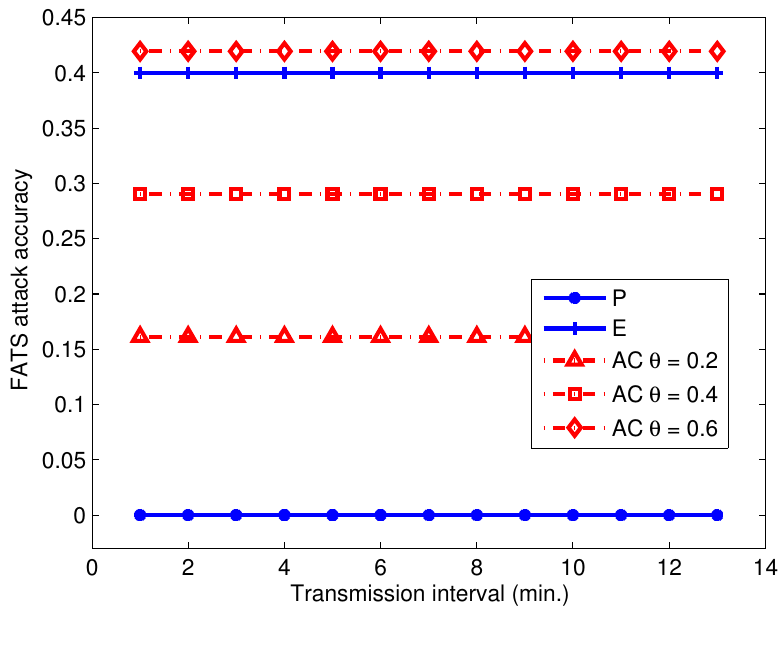
Figure 9. Privacy level of different protection methods.